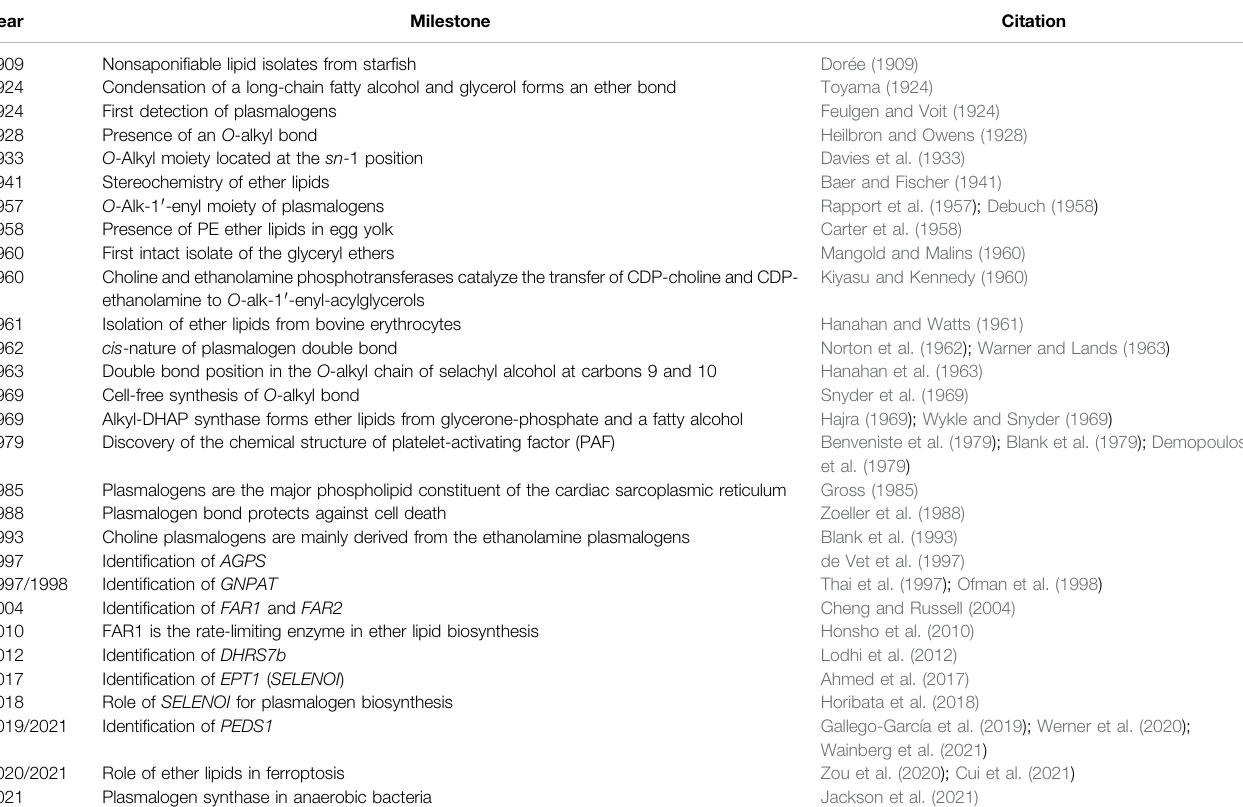
TABLE 1 | Milestones in plasmalogen research [expanded on the basis of Snyder